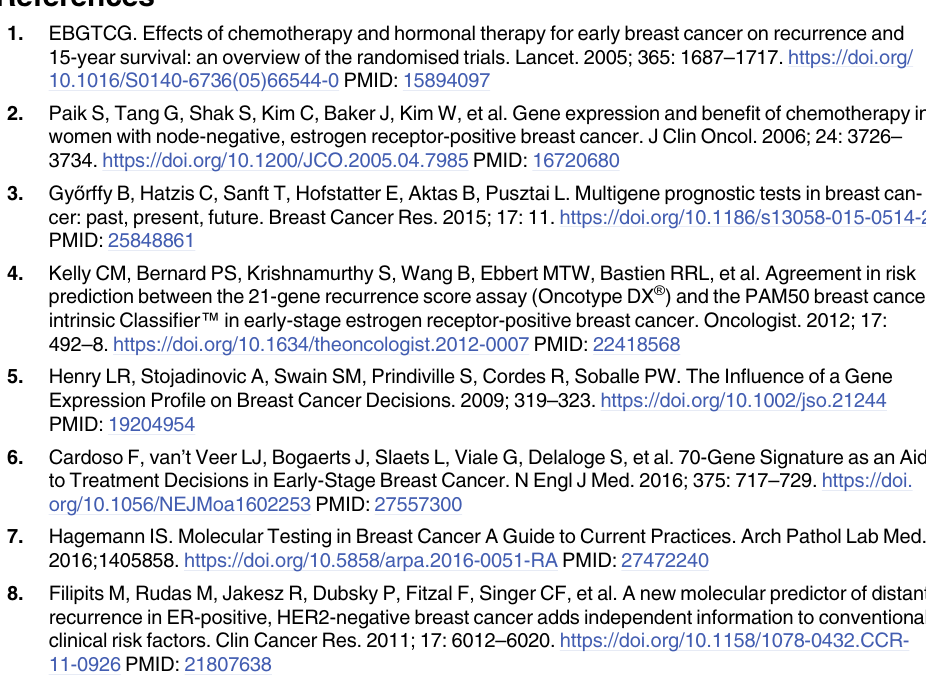
S1 Table. Detailed description of clinical, pathological, immunohistochemical, and molec- ular data of the patients included in the